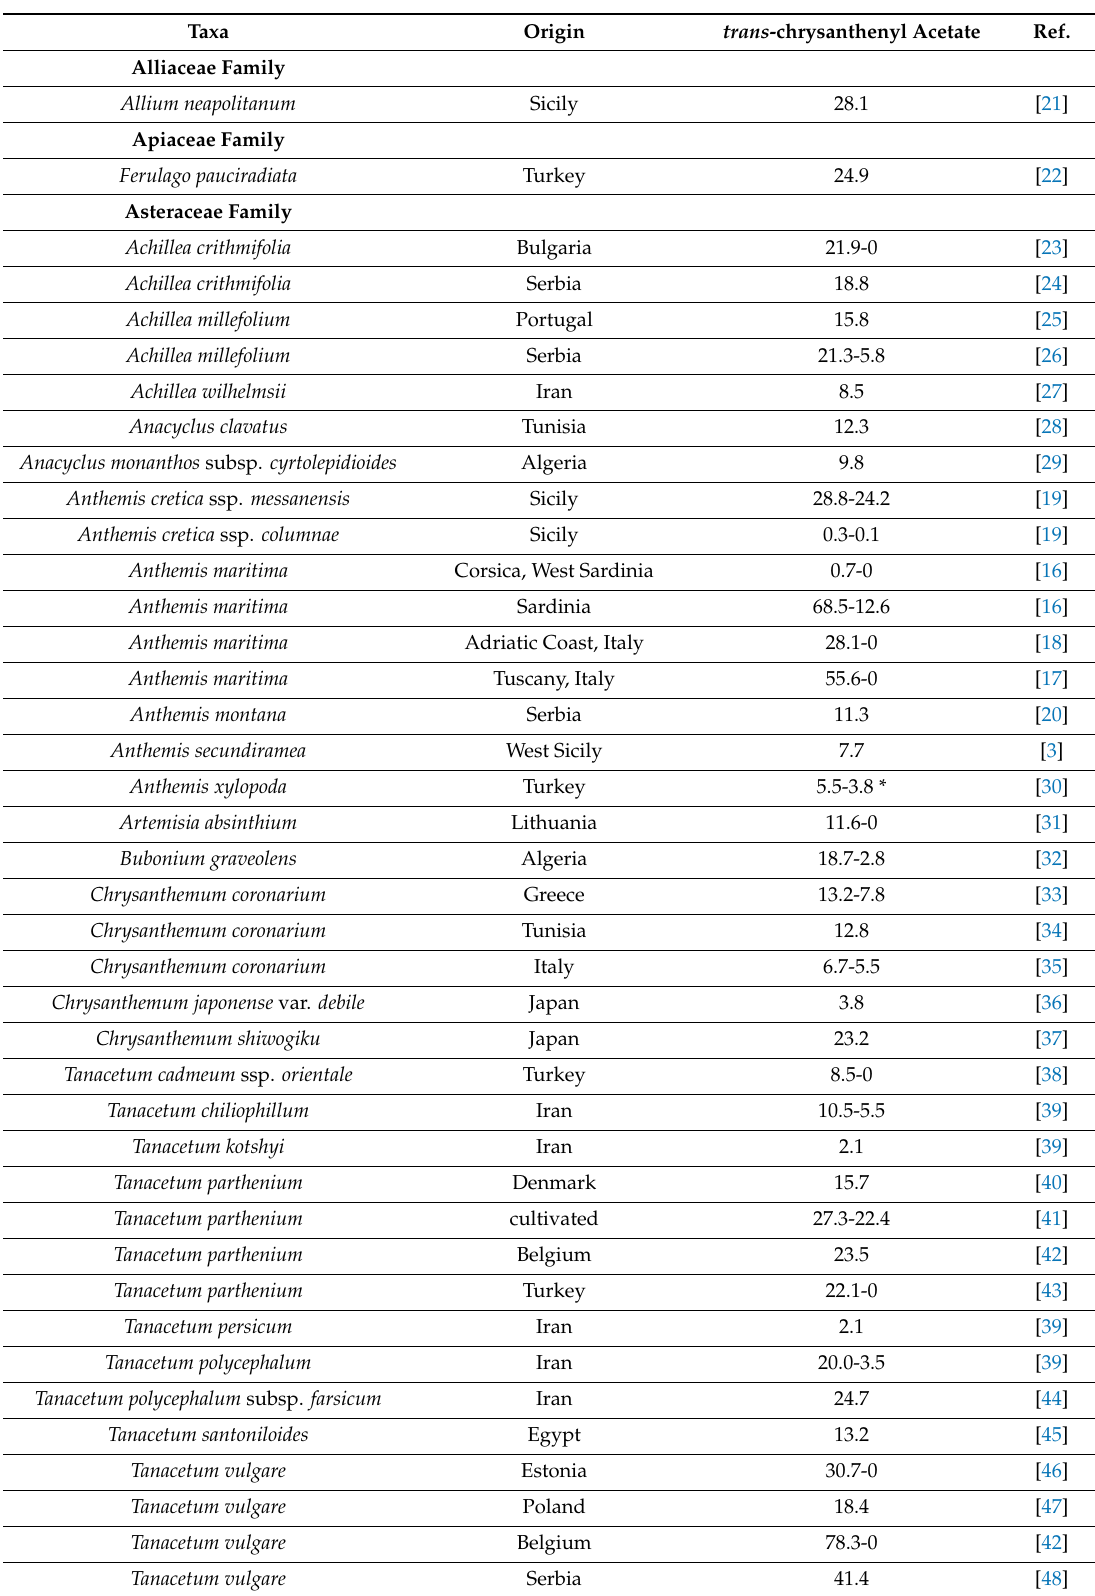
Table 2. The occurrence of ( E )-chrysanthenyl